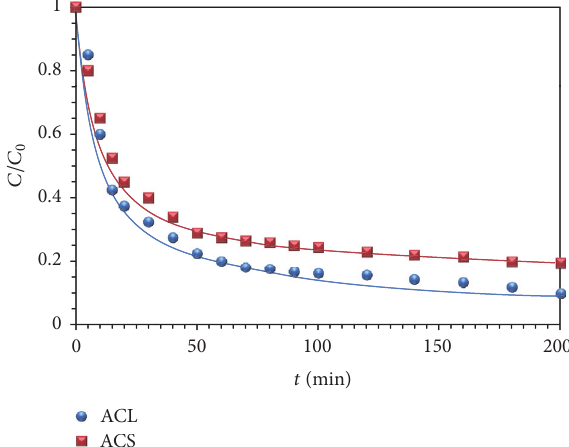
Figure 4: Effect of contact time on the adsorption of lead from aqueous solution, using ACS and ACL ( 𝑇 = 25 ∘